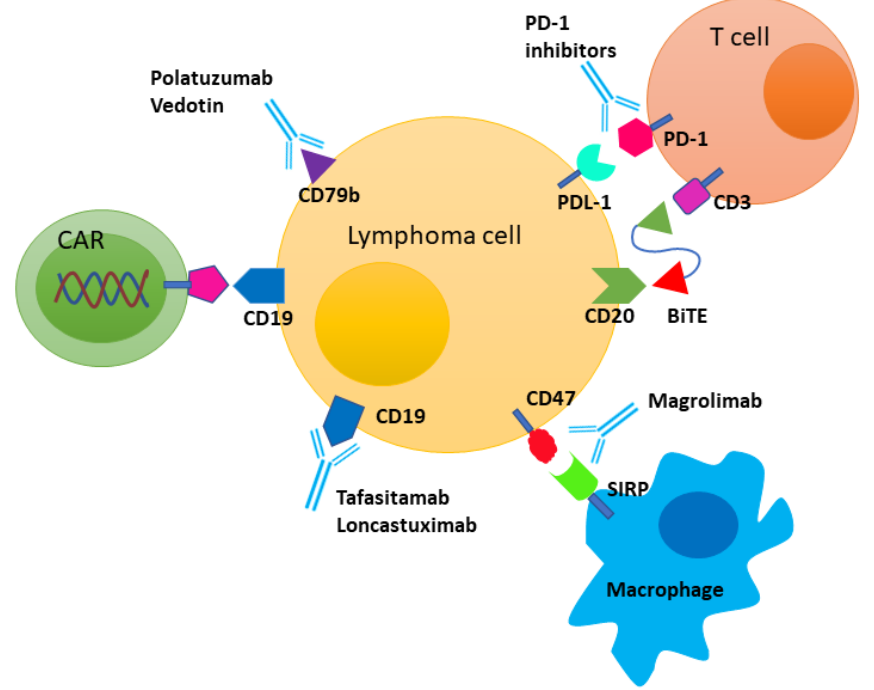
Figure 1. Overview of the interaction between malignant B-cells and other immune cells in the tumor microenvironment, and the therapeutic targets in diffuse large B-cell lymphoma. CAR: Chimeric antigen receptor; BiTE: Bispecific T-cell engager; SIRP: Signal regulatory protein. Table 2. Clinical trials of CAR T-cell therapy in lymphoma.